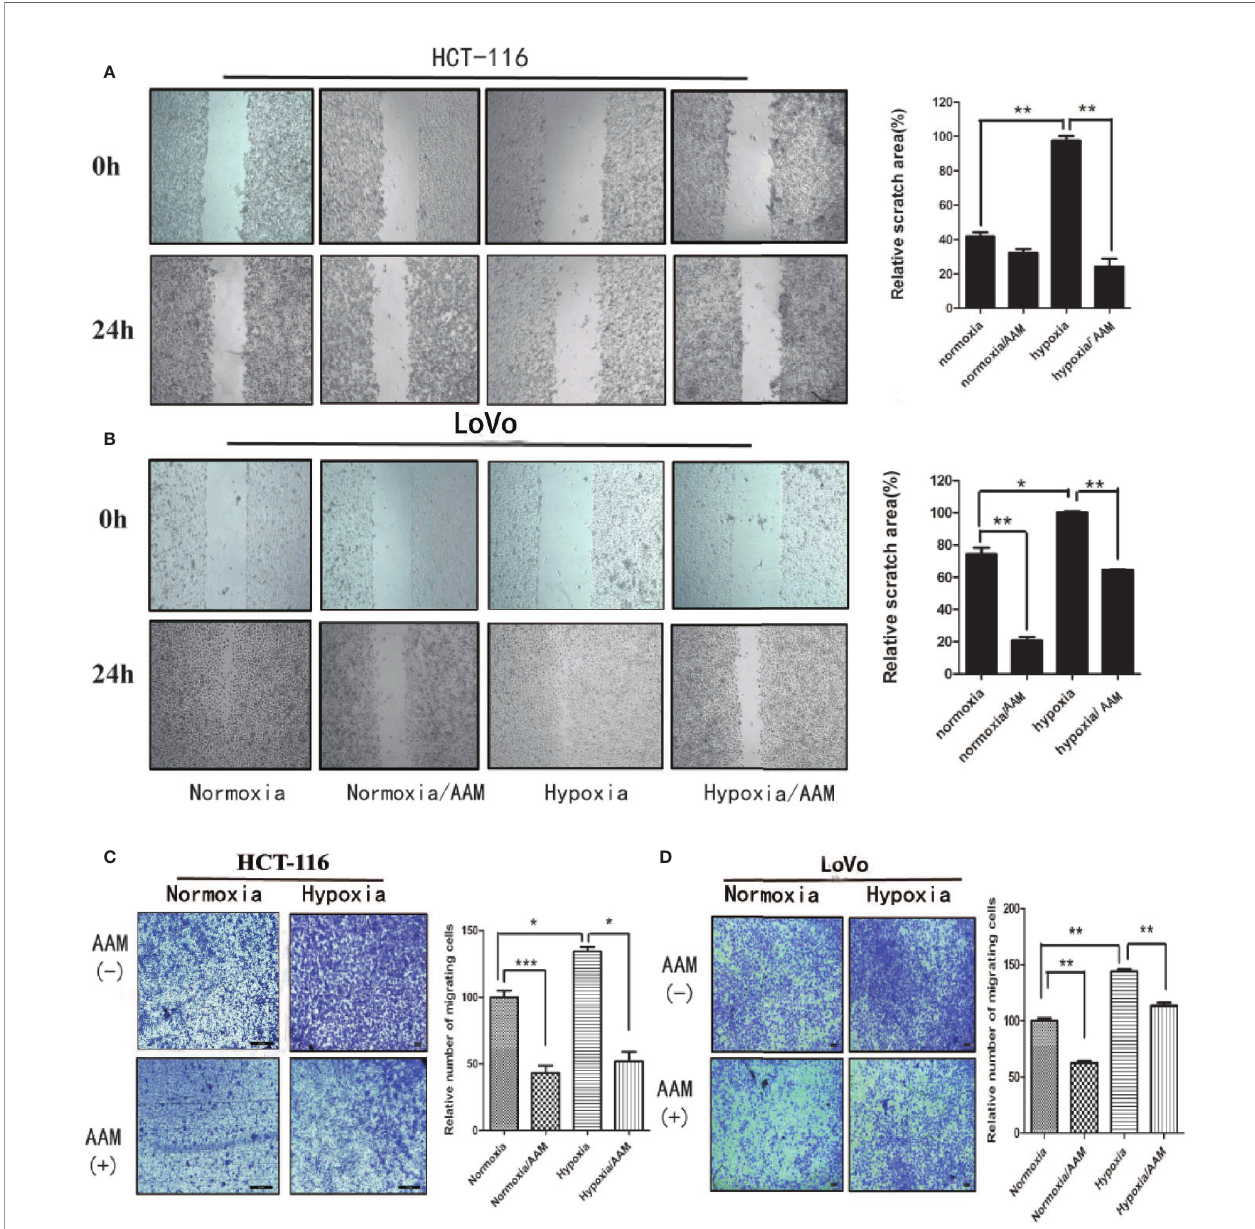
FIGURE 8 | AAM inhibits migration of HCT-116 and LoVo cells. (A, B) Wound-healing assays of HCT-116 and LoVo cells. The cells were treated with medium alone, AAM (2.5 mg/ml), hypoxia medium, hypoxia medium with AAM (2.5 mg/ml) for 24 h. The representative images were shown in magni fi cation of 100×. (C, D) Transwell assay was used to evaluate the effect of AAM on HCT-116 and LoVo cell migration. Migrated cells were stained and captured by microscope (50×); cell numbers are compared between groups. (* P < 0.05, ** P < 0.01, *** P <